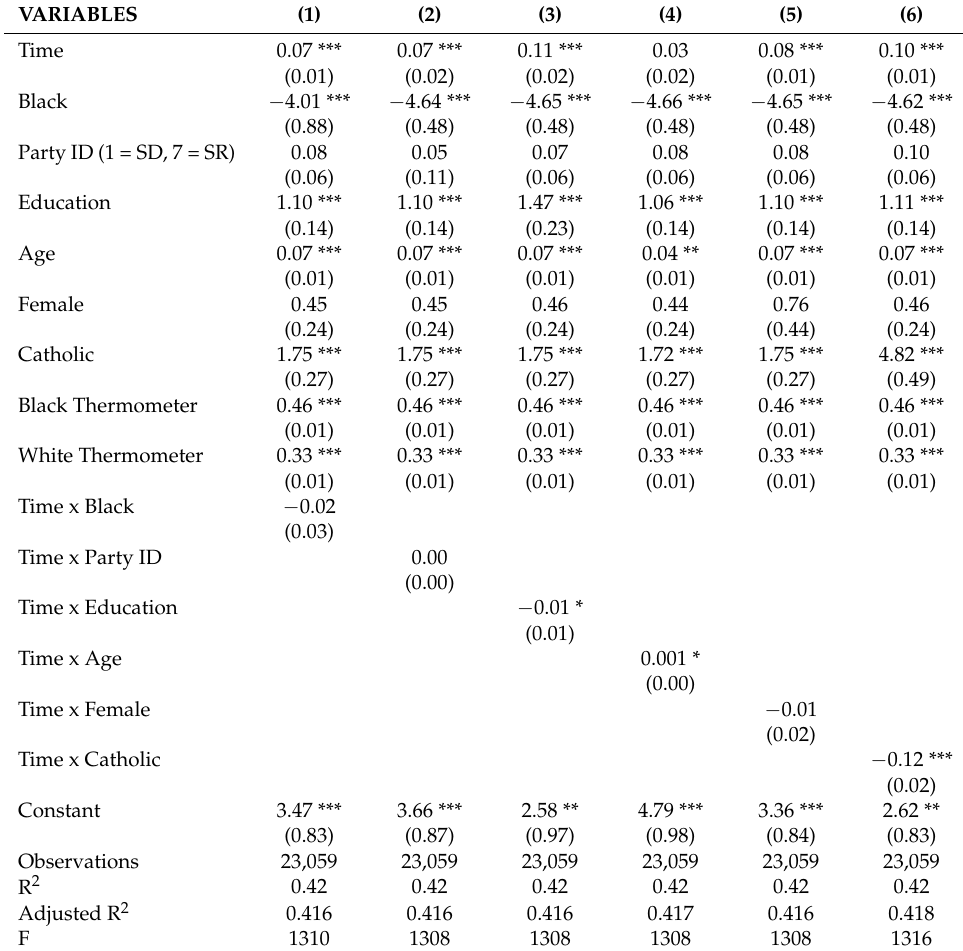
Table 3. Impact of demographics, time, and their interaction on Jewish thermometer ratings, ANES